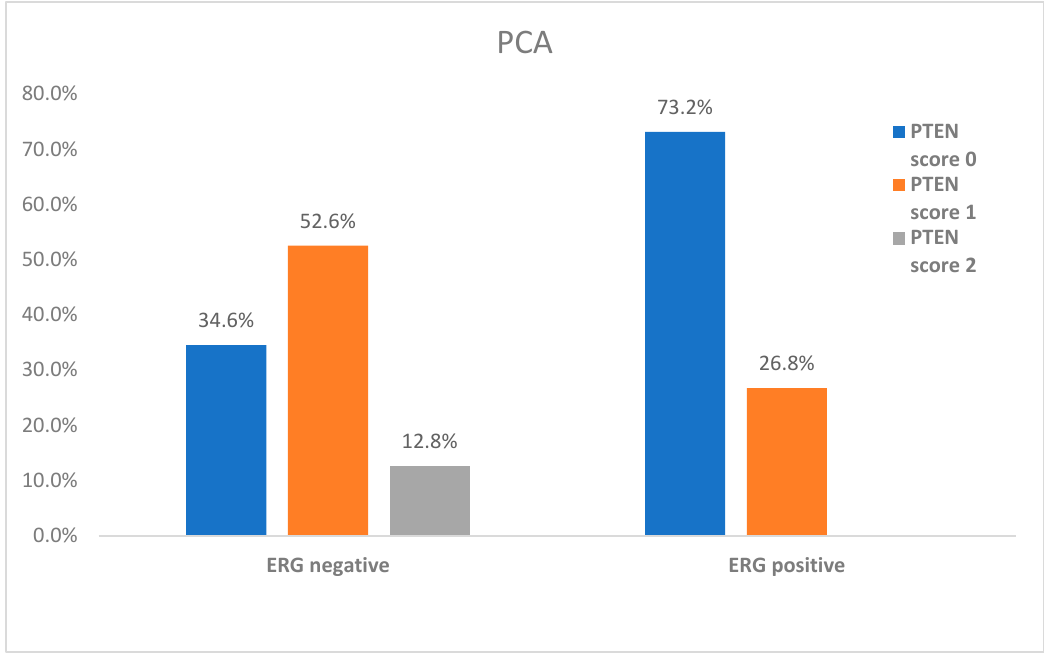
Figure 1. Interrelations between ERG and PTEN immunoexpression in prostate cancer.